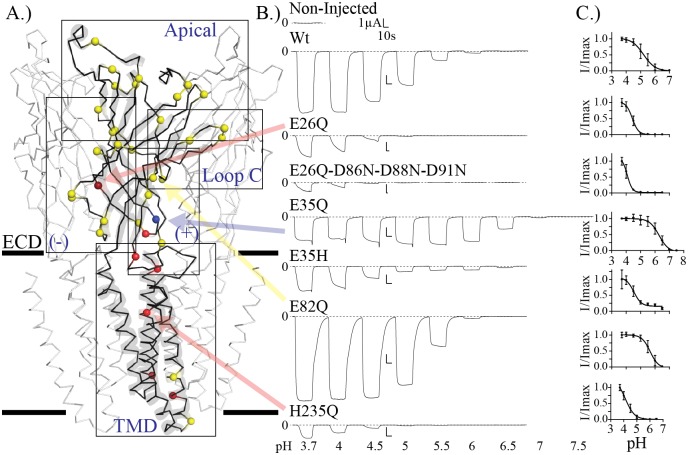
Overview and typical current traces.(A) Three subunit view of the pH 4, apparently open-form, structure of GLIC (PDB ID: 4HFI), with solid black bars representing the membrane level. The central subunit is shown in black ribbon and transparent cartoon representation and the neighboring subunits are in white ribbon. Titratable Asp/Glu/His residues are shown as Cα spheres, color-coded based on mutation results with pH50 decreasing, increasing, and no significant change colored red, blue, and yellow, respectively. The outlined boxes represent the regions of interest (TMD and ECD: apical, basal complementary [−], and principal [+] faces, along with Loop C) present in subsequent figures. (B) Typical traces of proton-elicited currents from prominent and interesting mutants. Traces are aligned and scaled in time to match the Wt trace. Vertical scale bars are identical, whereas horizontal scale bars vary depending on perfusion time required to achieve maximal currents. The dashed line represents 0 μA current. Loss of function mutants (smaller pH50) generally had slower rising phases requiring longer activation perfusions. For example, with the quadruple mutant, the current did not reach a maximum within two min of perfusion at any pH value. Some gain-of-function mutations on the other hand, required longer rinse times to recover the baseline. (C) Normalized dose-response curves for the corresponding mutants represented in (B). Plots are mean ± standard deviation for I/Imax of all recorded values noted in S1 Table for the given mutant, where Imax is the average absolute current for the maximal pH value per oocyte tested. ECD, extracellular domain; GLIC, G. violaceus ligand-gated ion channel; I, current (μA); PDB ID, protein data bank identification code; TMD, transmembrane domain; Wt, wild-type.